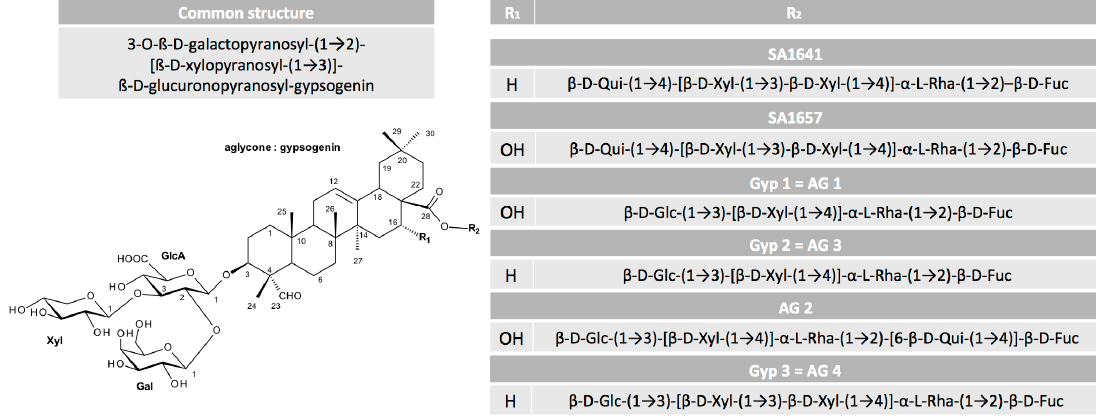
Figure 1. Relevant structural characteristics of the oleanane type triterpenoid saponins. The figure provides an overview on those saponins, for which the complete structure has been published to